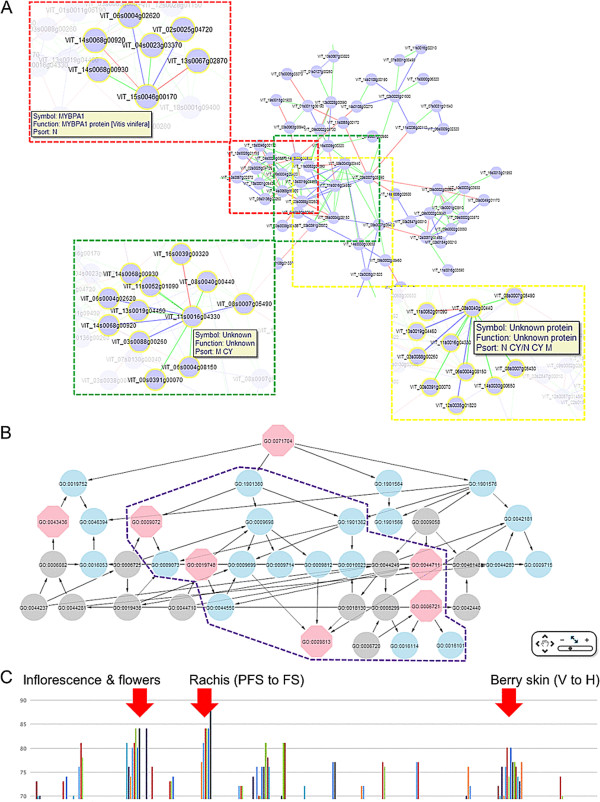
Predicted module involved in flavonoid, amino acid and related metabolism (module All _HCCA_181). (A) Output for module ‘All _HCCA_181’, which contains 74 nodes and 152 edges, includes genes predominantly associated with general flavonoid, aromatic amino acid metabolic pathways and transport. Sub-network of putative grapevine MYBPA1 and two unknown genes extracted from module ‘All _HCCA_181’ within a neighbourhood distance of 1 are highlighted in red, green and yellow boxes, respectively. (B) Network representation of truly significant and highly enriched GO:BP terms related to flavonoid, aromatic amino acid and terpenoid metabolism are highlighted in purple boxes. Other enriched GO terms were removed from presentation for clarity. (C) Expression specificity of module ‘All _HCCA_181’ showing experiments in which the probesets (70% or greater) demonstrated specific expression (Std2Gx > 1.0). PFS, post fruitset; FS, fruitset; V, veraison, H, harvest.